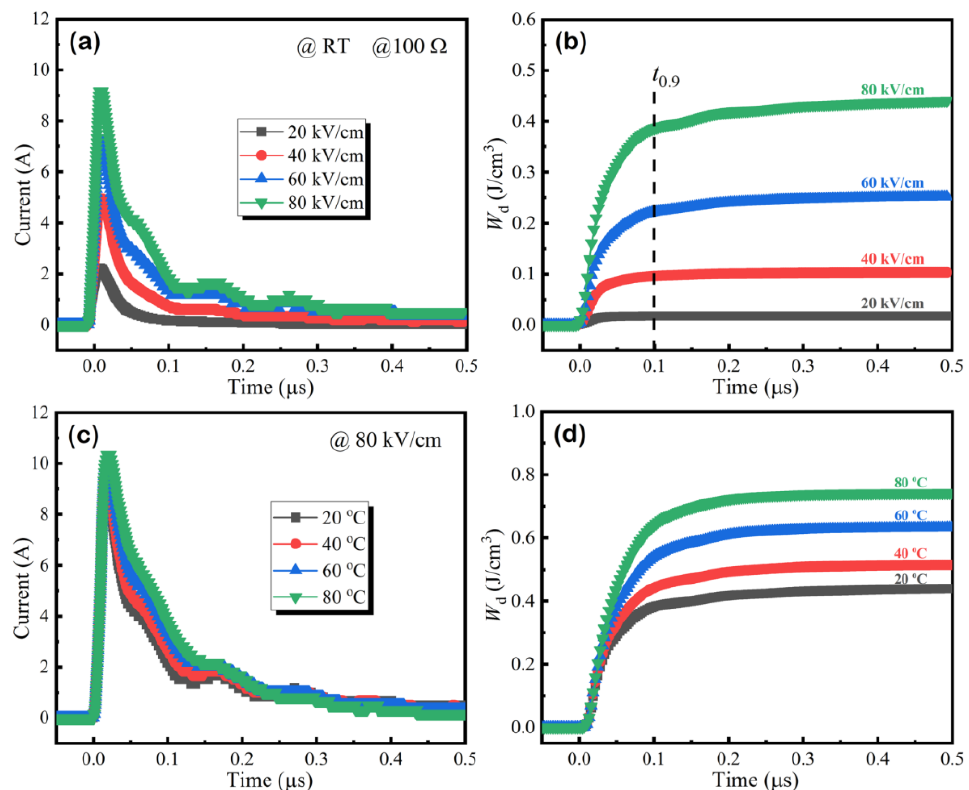
Fig. 8 (a) Overdamped discharge current curves and (b) corresponding discharge density W d as a function of electric field for x = 0.06 ceramics at room temperature, (c) overdamped discharge current curves, and (d) corresponding discharge density W d as a function of temperature for x = 0.06 ceramics at 80